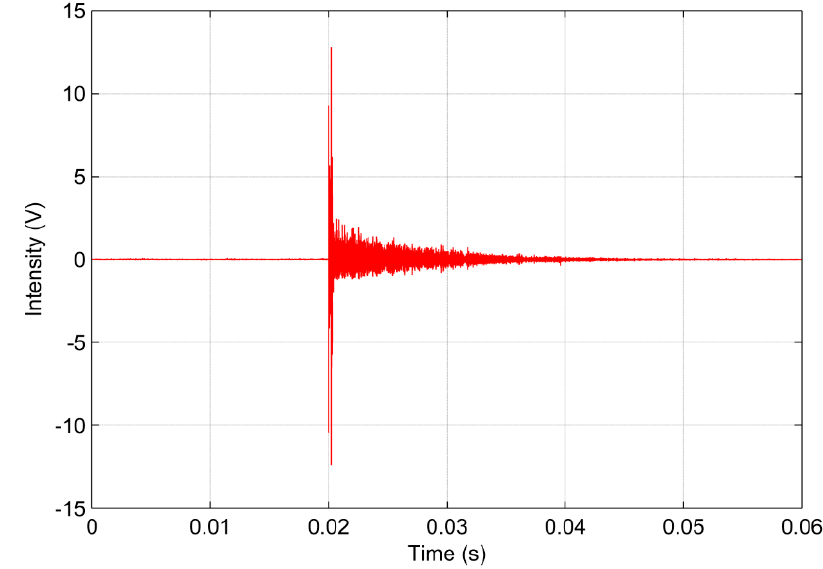
Figure 7. Partial discharge signal in the time domain obtained for the conventional AE sensor.